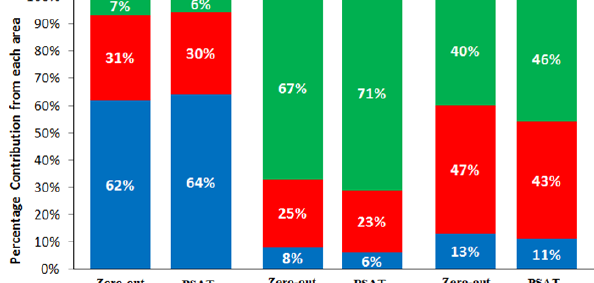
Fig. 10. Comparison of simulated and measured contributions of local and regional sources for EC, sulfate and OA for the summer and winter periods. Fig. 11. Simulated contributions of emissions from different source areas to EC, sulfate and OA concentrations during the summer in Paris for the zero-out approach and